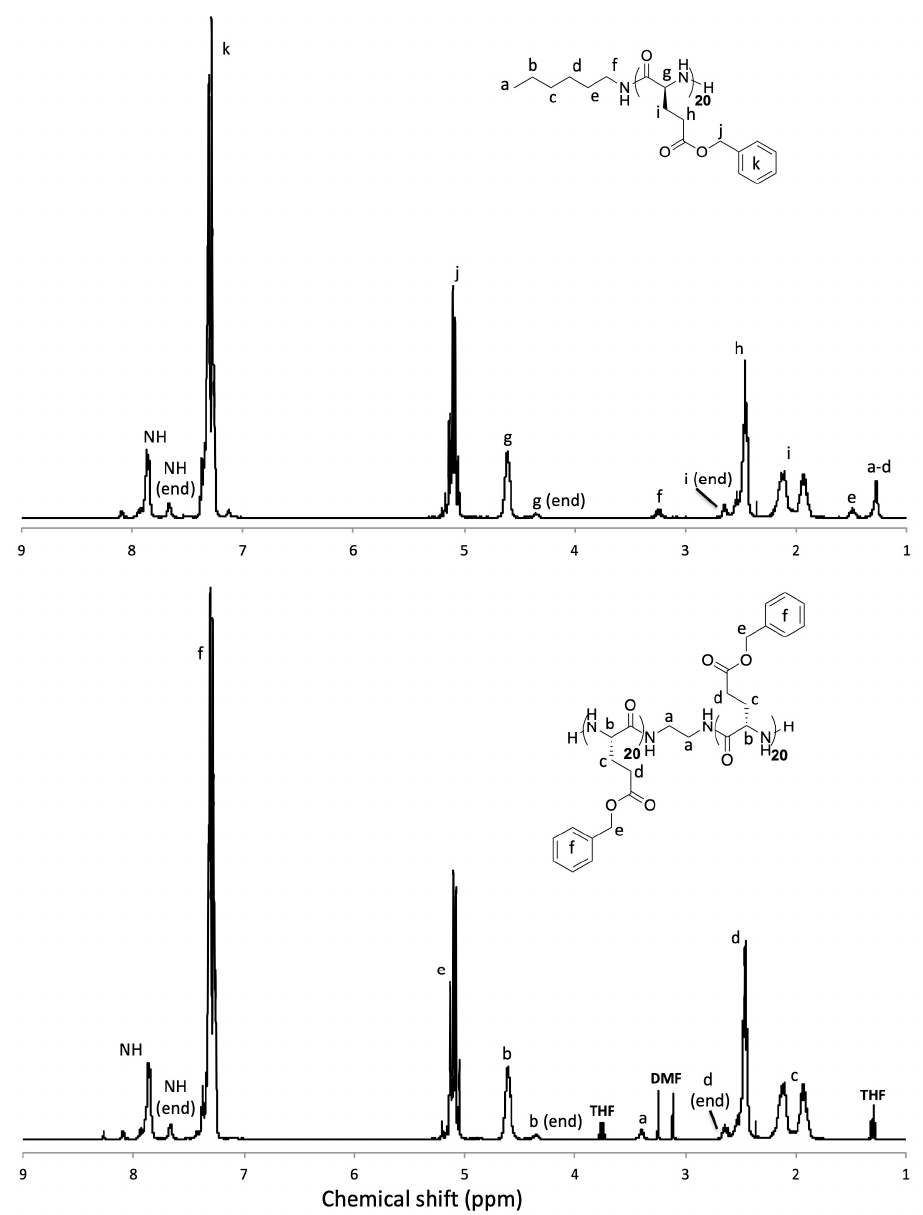
Figure 1. 1 H NMR analyses of the macroinitiators—PBLG (top) and PBLG-ED-PBLG (down) (solvent: CDCl 3 + 15% TFA).